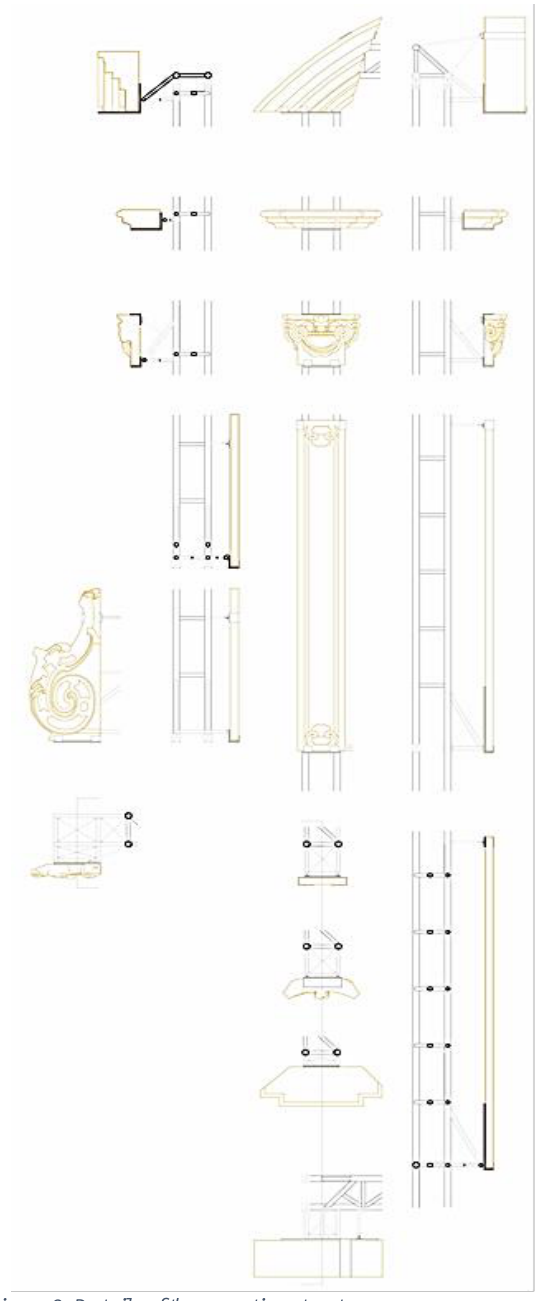
Figure 9. Details of the mounting